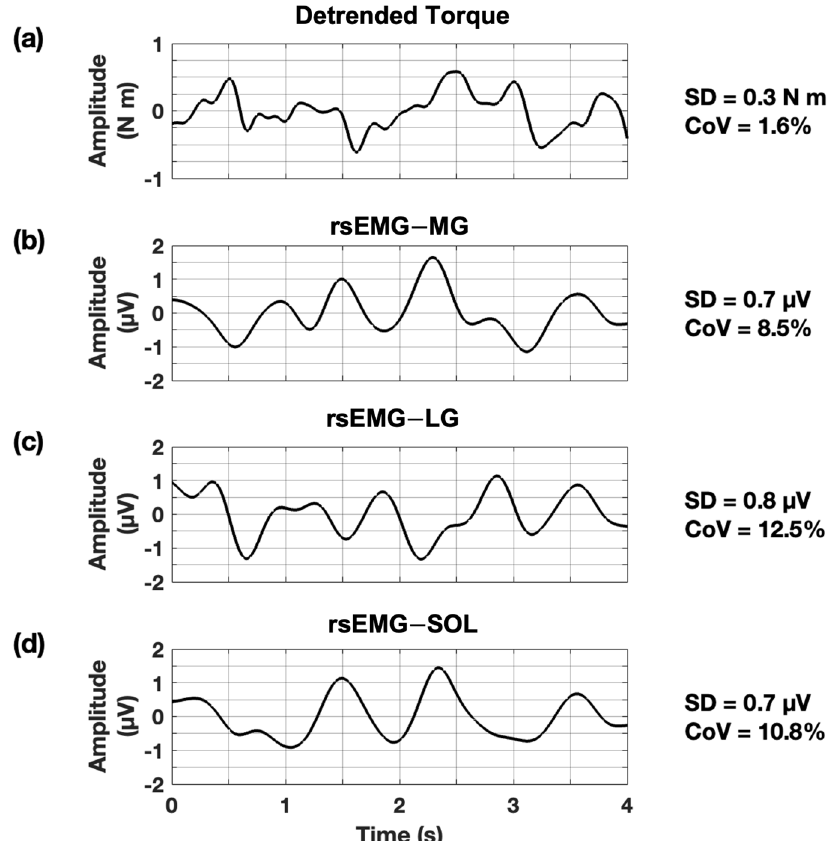
Figure 2. ( a ) Typical force trials of 30%MVIC for 4 s at longer muscle length from a representative subject. ( b ) From the same segment in ( a ), rsEMG from MG muscle; ( c ) rsEMG from LG muscle; ( d ) rsEMG from SOL muscle. All are detrended signals.